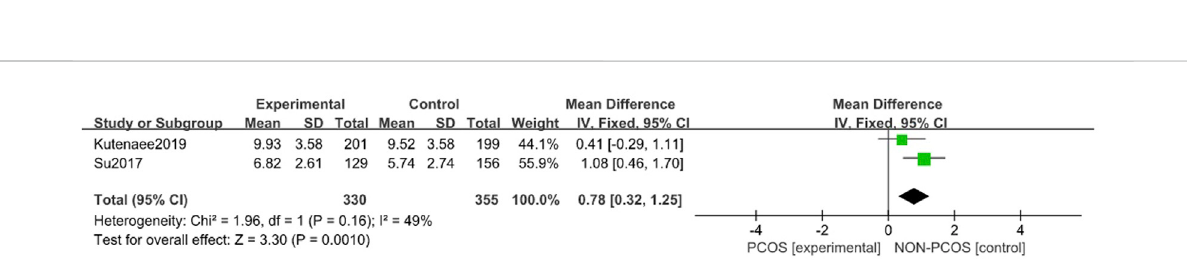
FIGURE 4 Forest plot of PSQI scores of sleep disturbance in PCOS group and control group.